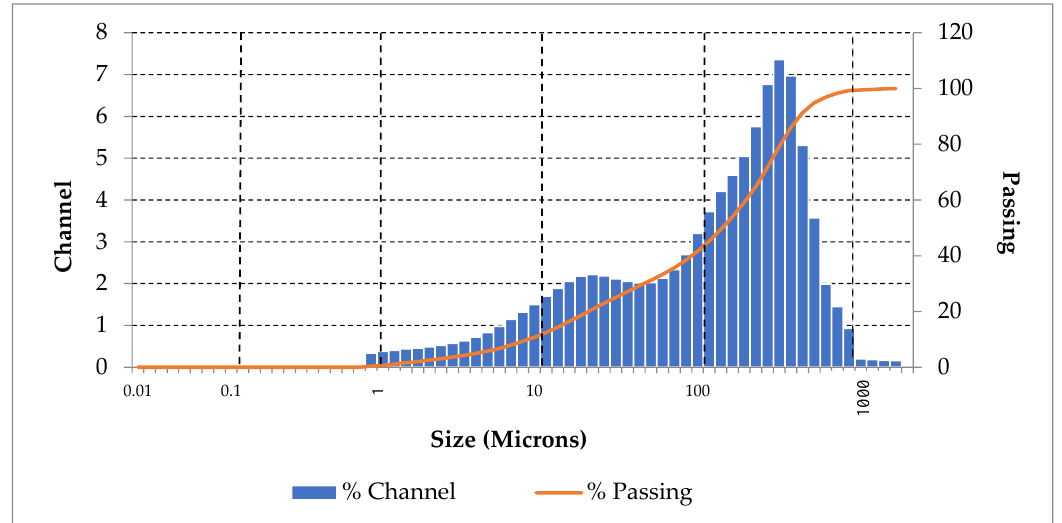
Figure 5. Cumulative sand passing percentage and channel – size distribution values.